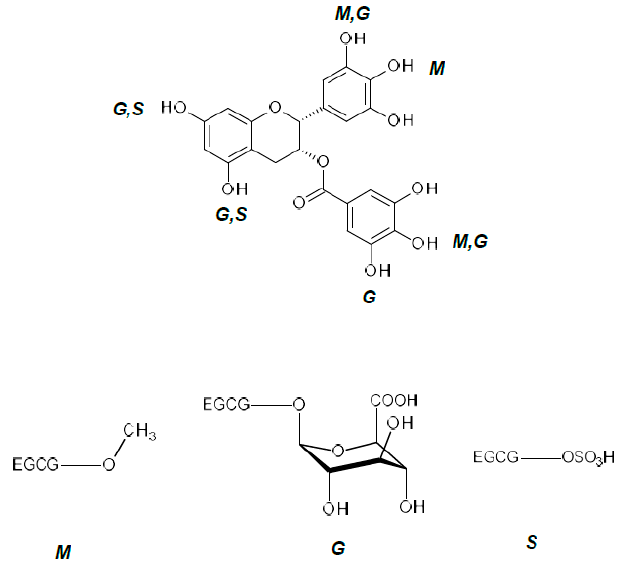
Figure 3. The possible sites of methylation (M), glucuronidation (G) and sulfation (S) of EGCG [89,90]. Chemical modification significantly modifies EGCG, raising questions regarding how or if these derivatives interact with proteins relevant to Down Syndrome.